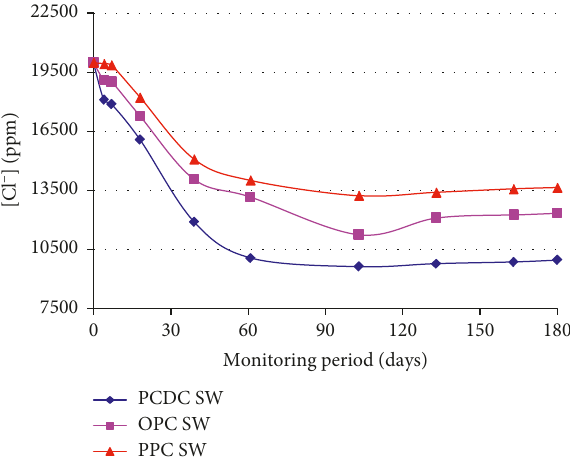
analyses in sea −